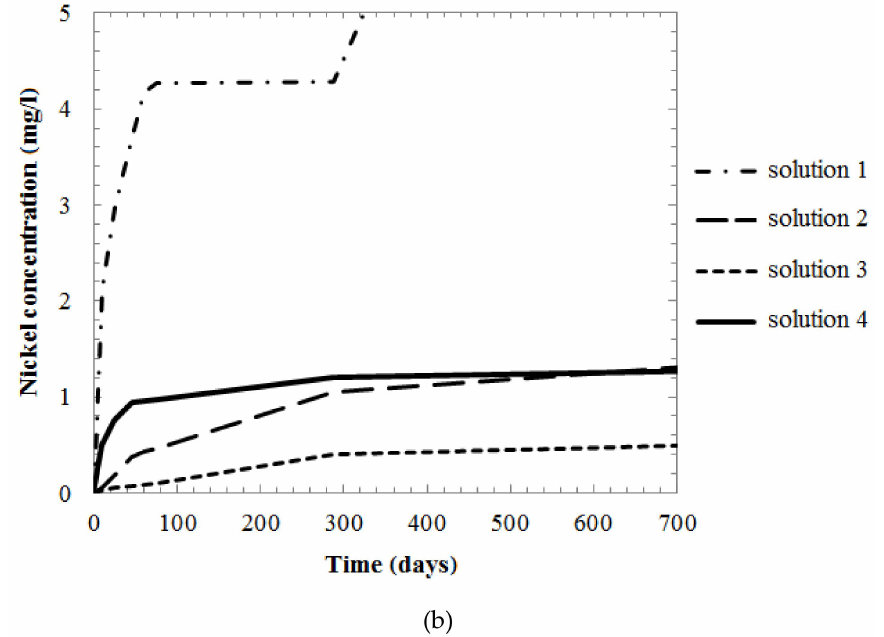
Figure 11. Changes in the concentration of ions dissolved from the as-received nitinol sample with time during immersion for 2 years: ( a ) nickel and titanium ion concentrations in a bu ff er solution at pH 1.68 (Solution 1, Table 1); and ( b ) nickel ion concentration in solutions with various acidities (Solution 1 – pH 1.68 bu ff er, Solutions 2 – pH 3.56 bu ff er, Solution 3 – pH 4.01 bu ff er, Solution 4 – NaCl, Table